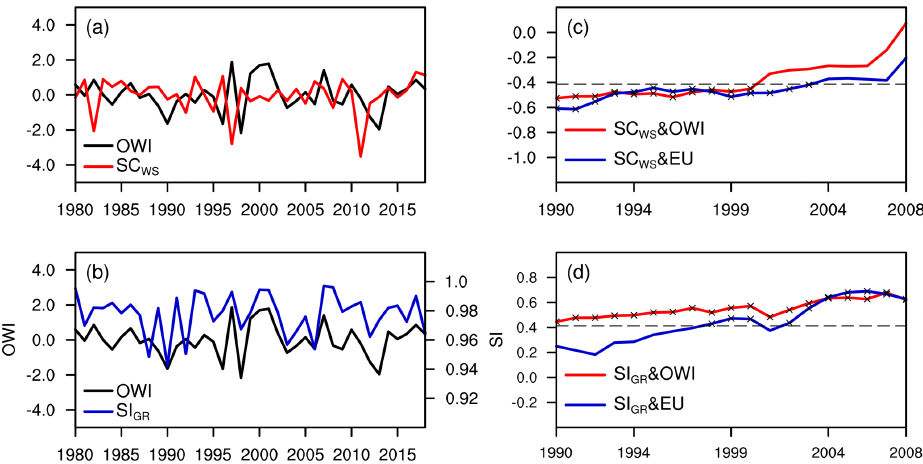
Figure 3. The normalized variation in (a) OWI (black) and SC WS (red), (b) OWI (black) and SI GR (blue) from 1980 to 2018 after detrending. The 21-year sliding correlation coefficients between (c) SC WS and OWI (red) and SC WS and EU (blue), as well as (d) SI GR and OWI (red) and SI GR and EU (blue). The black dotted line (crosses) indicates (exceeded) the 95% confidence level. The linear trend is removed.